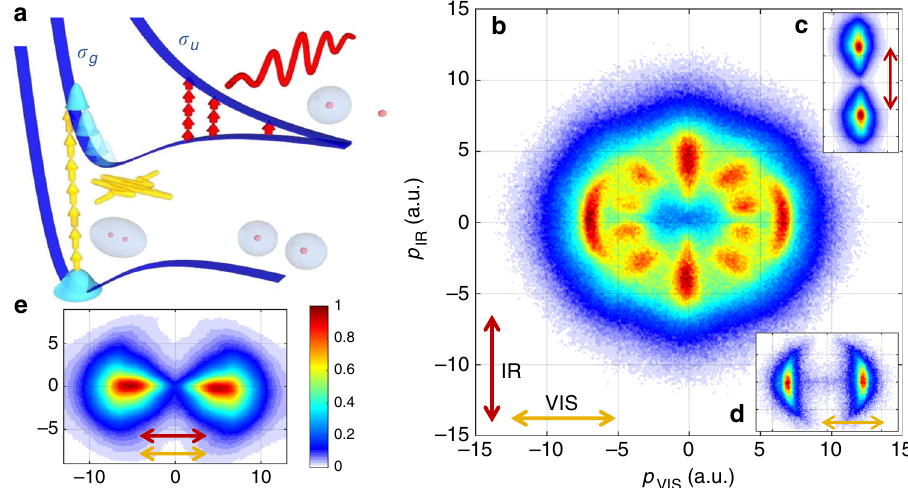
Fig. 2 Experimental signatures of LIPs. a A few-cycle visible pulse (yellow) ionizes H 2 and prepares a wave packet on the σ g state of the molecular cation. An additional mid-infrared control pulse (red) couples the σ g and σ u states by 1, 3, or 5 photons, creating LIPs, on which H 2 + dissociates into an H atom and a proton. b The measured proton momentum distribution in the recoil frame for perpendicularly polarized two-color fi elds (730 nm, 5 fs, 2 × 10 14 W/cm 2 , and 2300 nm, 45 fs, 3 × 10 13 W/cm 2 ) probes the LIPs. It strongly contrasts results obtained for c only mid-IR pulses (2000 nm, 65 fs, 1 × 10 14 W/cm 2 ) or d only visible (730 nm, 5 fs, 2 × 10 14 W/cm 2 ) pulses. The angular structure is moreover absent in two-color experiments carried out with parallel polarization ( e ). The data has been integrated over the direction perpendicular to the polarization plane. The arrows indicate the polarization axes of the visible (orange) and mid-IR (red) laser pulses. The color scale represents the measured proton yield normalized to the maximum value in each